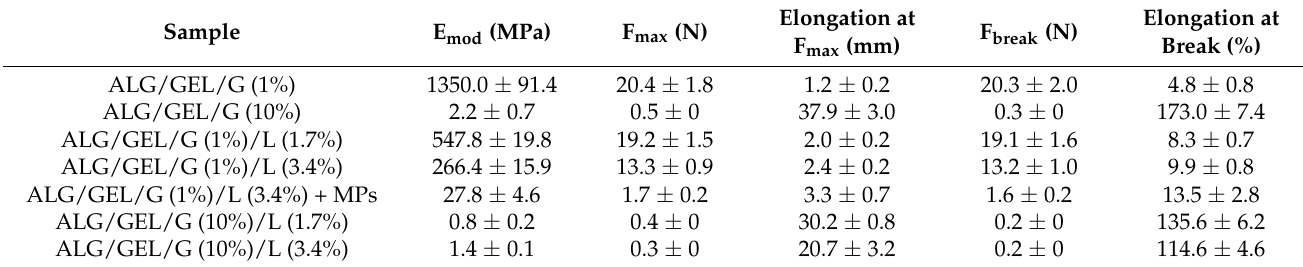
Table 4. Mechanical properties (Young’s modulus (E mod ), maximum force (F max ), elongation at maximum force, break force (F break ) and elongation at break) of films based on sodium alginate and gelatin with different amounts of glycerol and lipids, as well as the sample with incorporated PLA